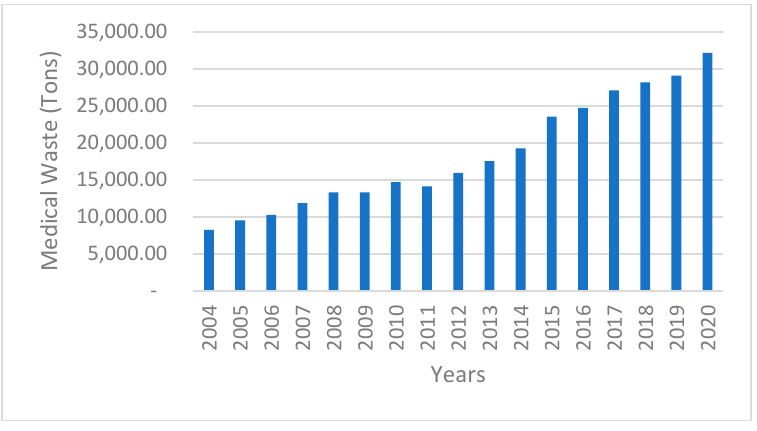
Figure 2. Annual MW amount of İ stanbul [40].